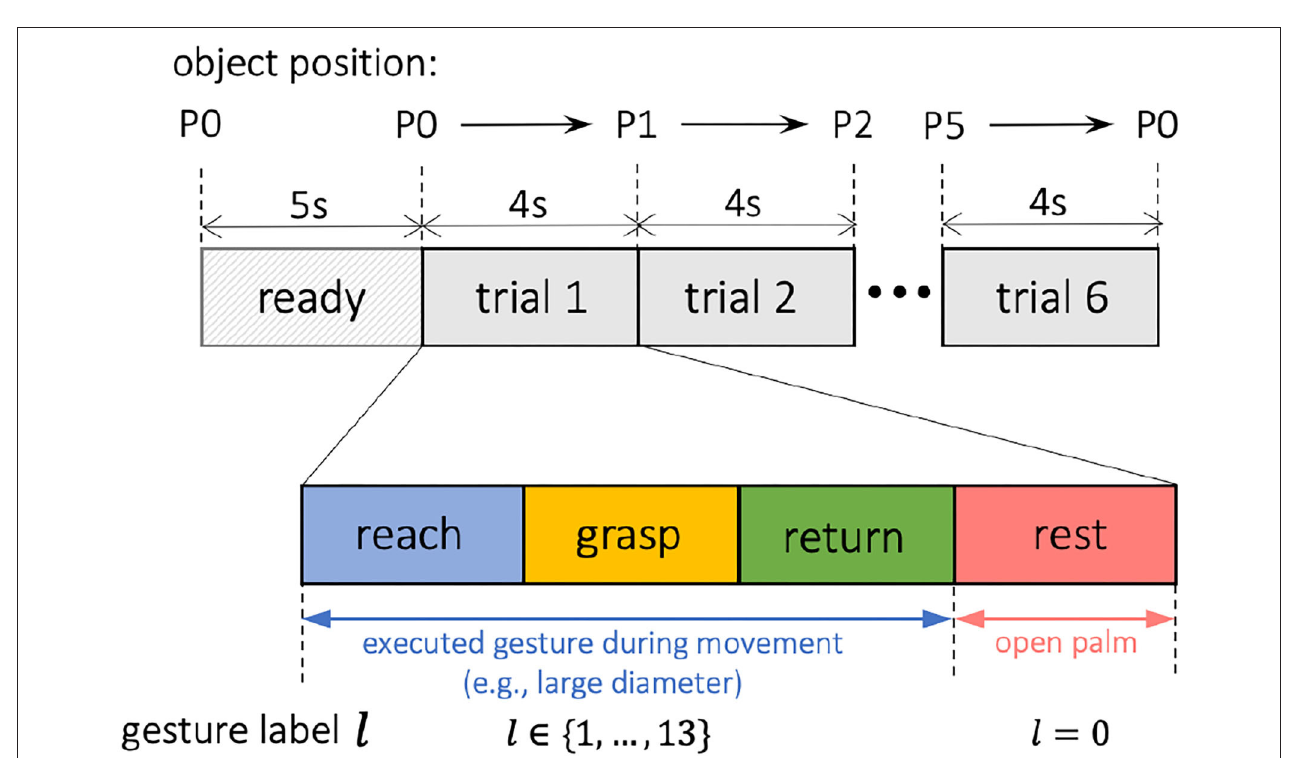
FIGURE 4 | Experiment timeline and the EMG segmentation and